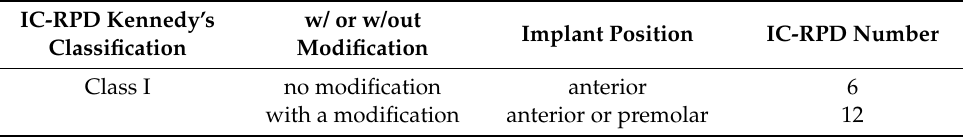
Table 1. Kennedy–Applegate classification in the implant-crown-retained removable partial denture (IC-RPD) group. IC-RPD Kennedy’s Classifi-